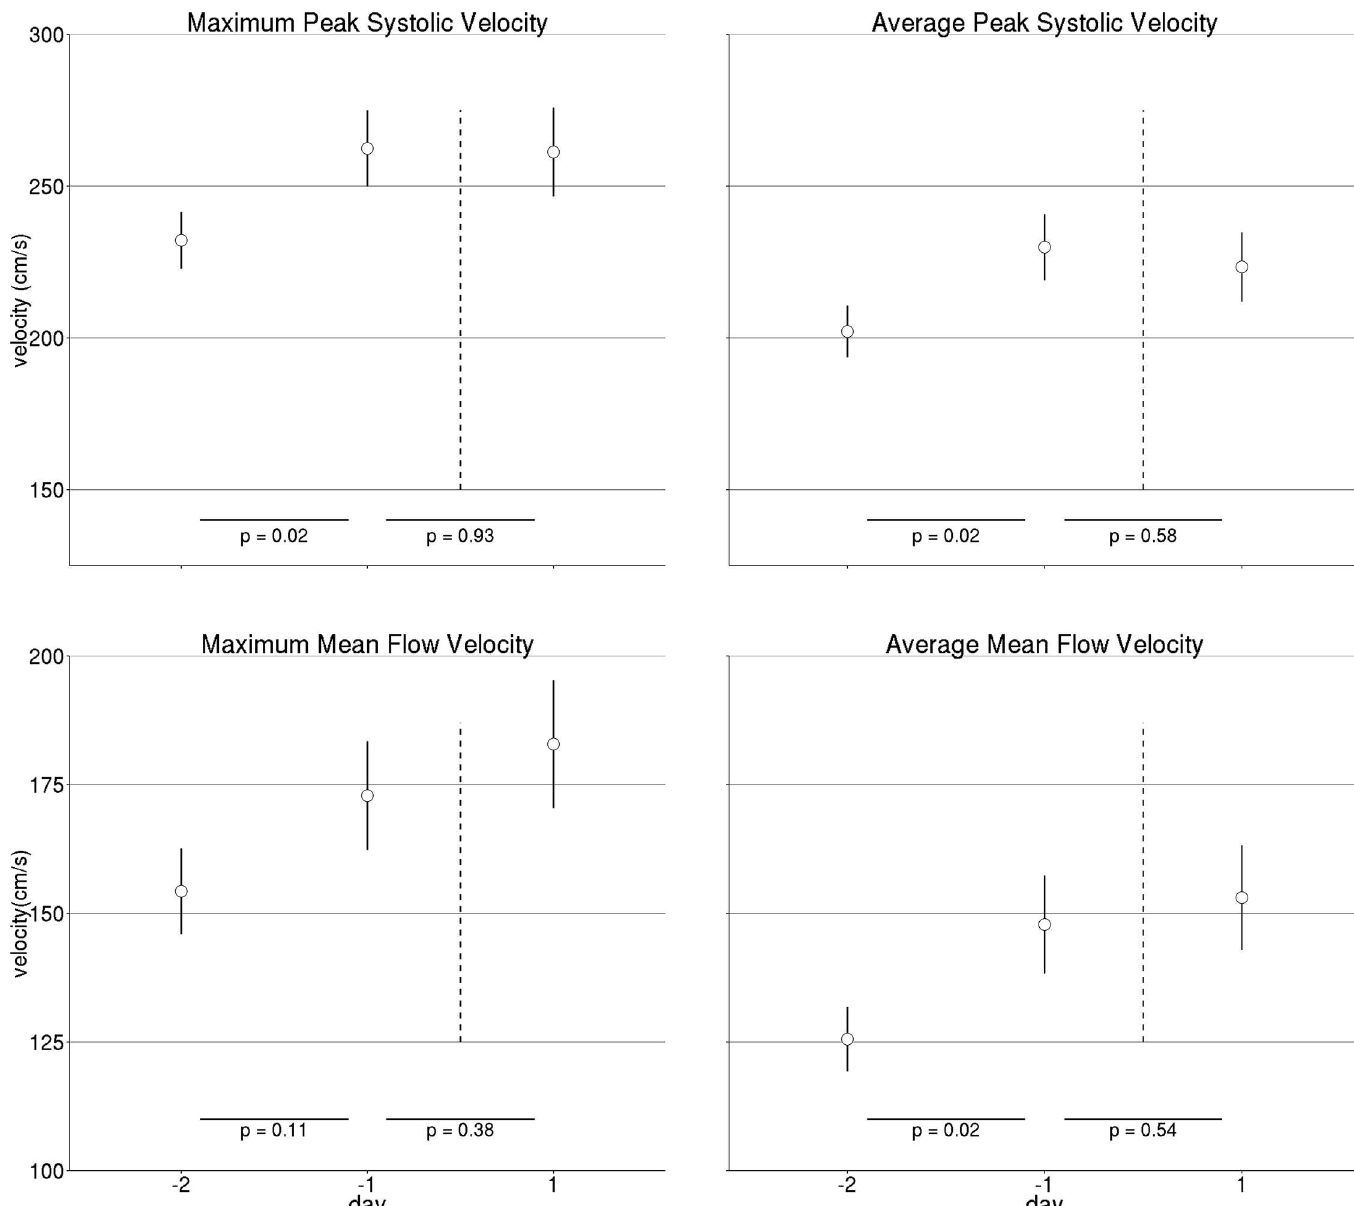
Fig 1. TCD Measures. TCD measures of middle cerebralarteries blood flow in 19 patients with aneurysmalsubarachnoid hemorrhage who received IA vasodilator treatment (a total of 33 infusions)two days before (day -2), a day before (day -1), and a day after (day 1) infusion. Dashedvertical lines mark the